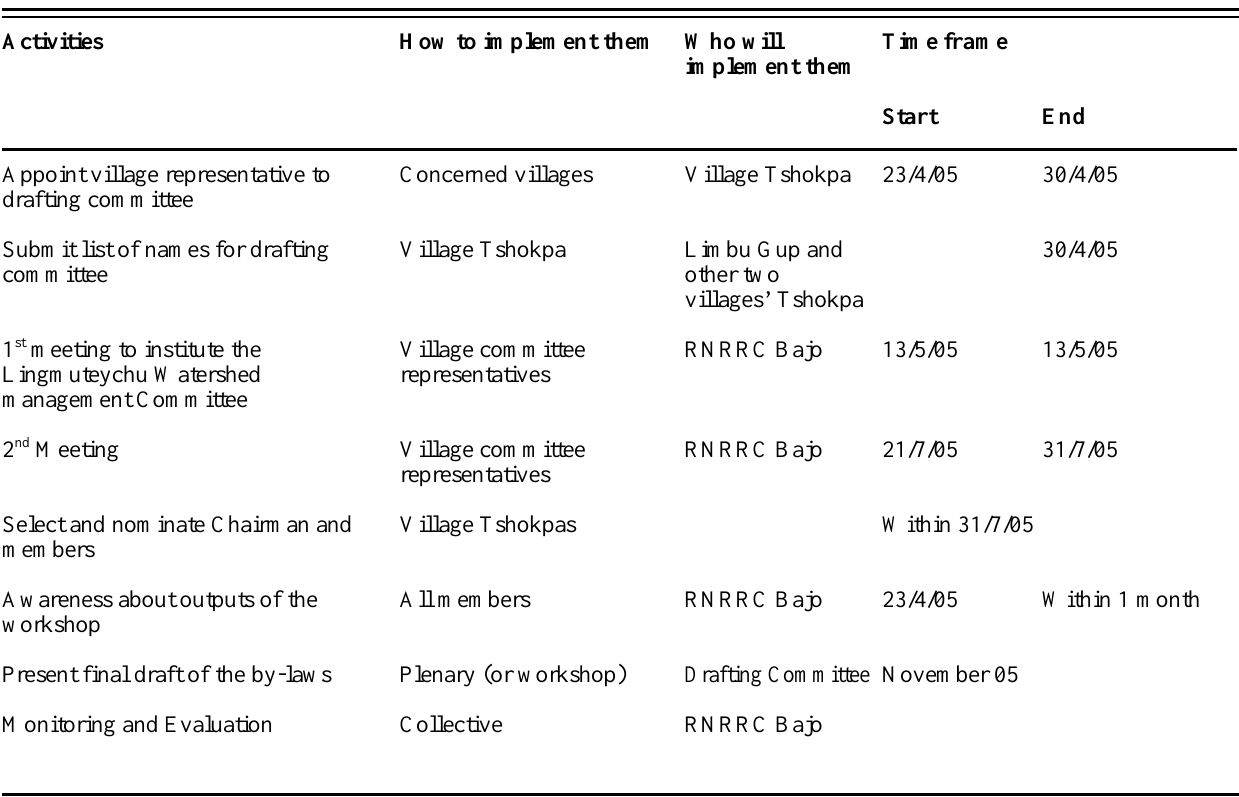
Table 10. Course of action for the next 7